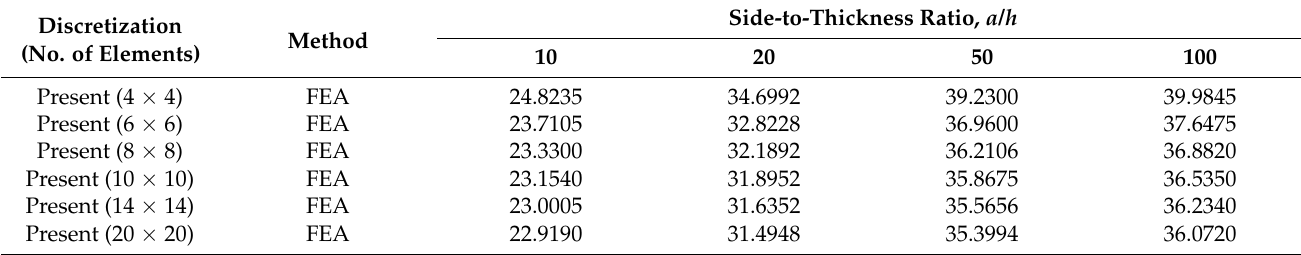
Table 3. Convergence study of nondimensional buckling loads, N = N cr α 2 / E 2 h 3 , for simply supported four-layered [0 ◦ /90 ◦ /90 ◦ /0 ◦ ] cross-ply laminated rectangular plate under uniaxial compressions with different side-to-thickness